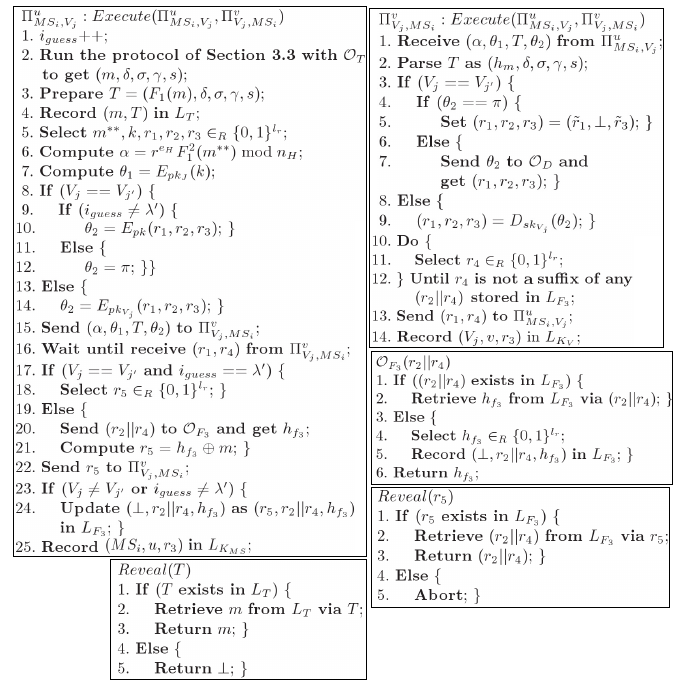
Figure A2. The oracles in the proof of Theorem